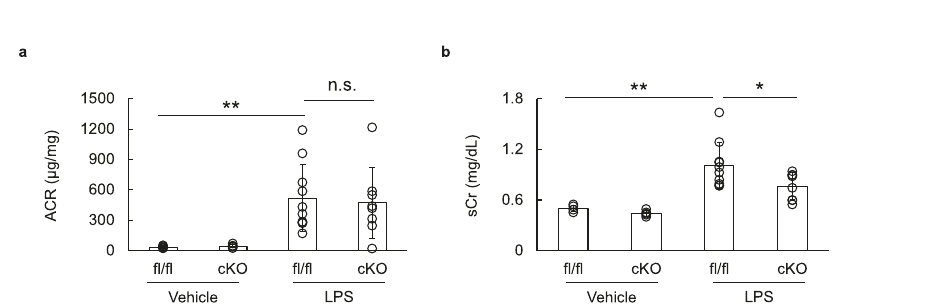
Fig. 2 Podocyte-restricted OASIS de fi ciency attenuated LPS-induced acute kidney dysfunction. a , b OASIS cKO and fl / fl mice were intraperitoneally administered with LPS, at a concentration of 10 mg/kg. Urinary albumin creatinine ratio (ACR) and serum creatinine (sCr) levels were measured 24 h after LPS injection. Data are shown as mean ± SD ( n = 5 for fl / fl -vehicle and cKO-vehicle, n = 10 for fl / fl -LPS, and n = 8 for cKO-LPS), * P < 0.05 and ** P < 0.01, as analyzed using Dunnett